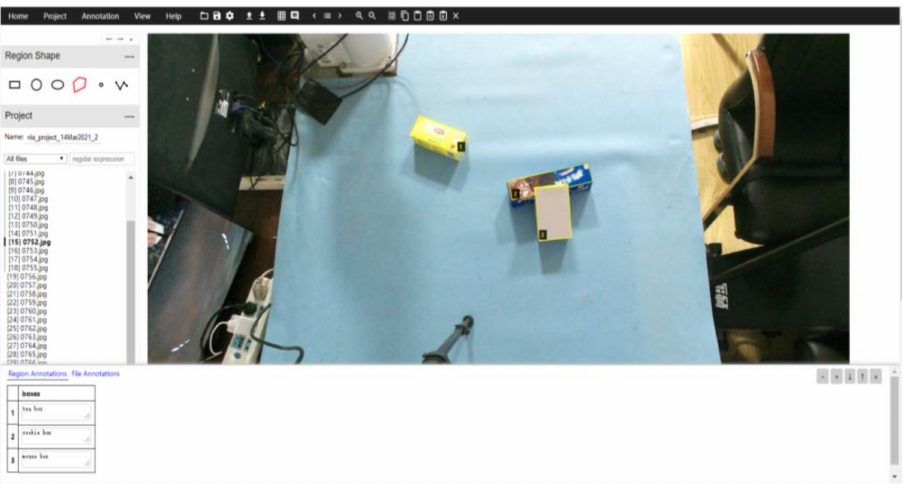
Figure 10. VIA Labeling